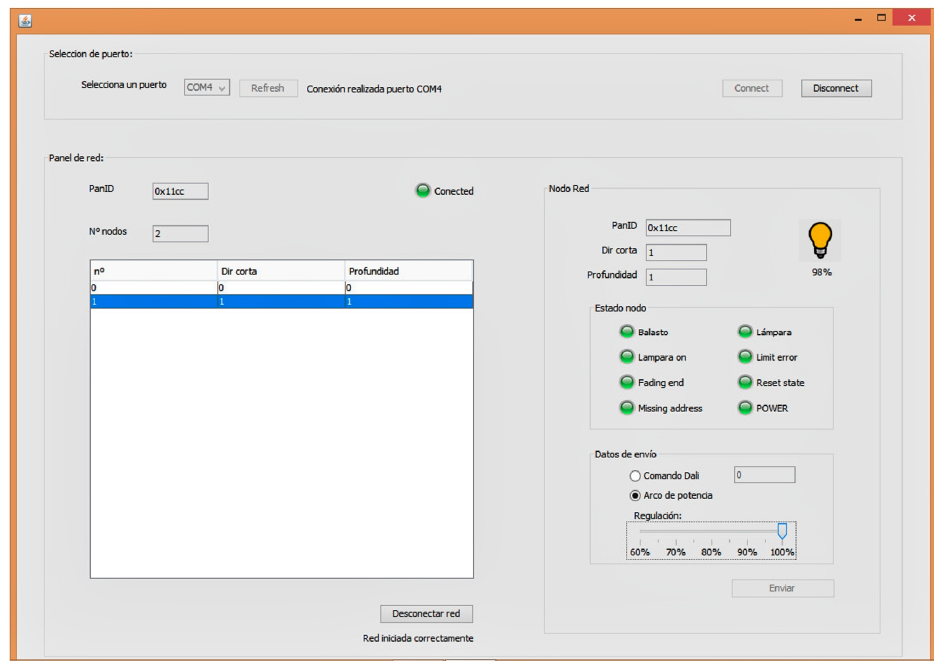
Figure 5. View of one of the windows of the local SCADA.